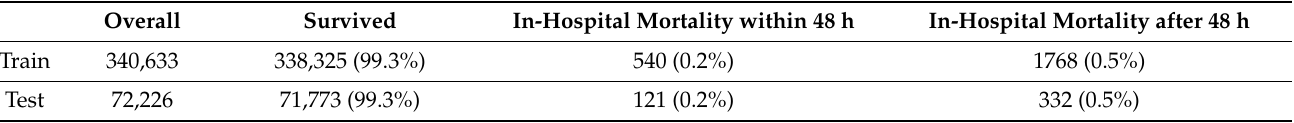
Table 2. Data distribution across the training and testing datasets.